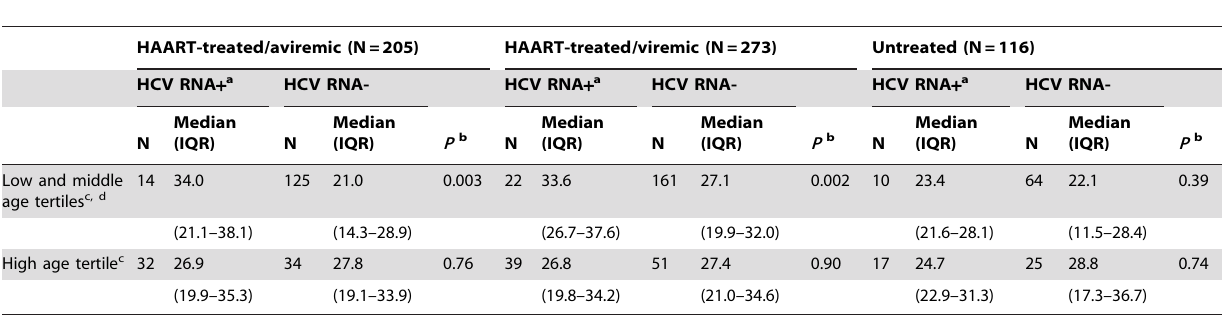
Table 2. Median CMV IgG levels (IU/mL) stratified by HCV RNA status, age tertile, and HIV treatment status among CMV- seropositive